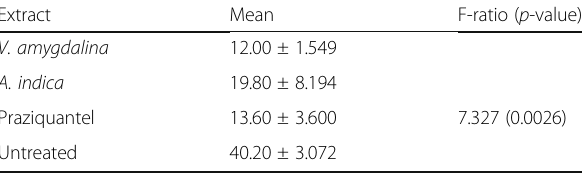
Table 2 Worms recovered from S. mansoni -infected mice Extract